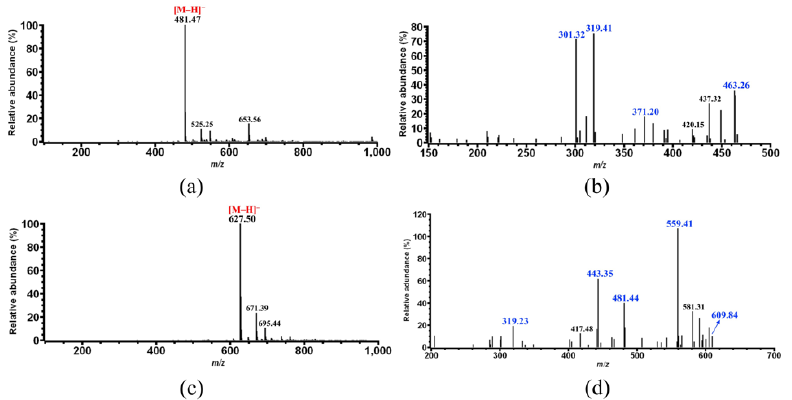
Figure 8. Identification of CP compounds 8 and 9 . ( a ) MS analysis of compound 8 ; ( b ) MS/MS analysis of the ion with m / z 481.47 obtained in ( a ); ( c ) MS analysis of compound 9 ; ( d ) MS/MS analysis of the ion with m / z 627.50 obtained in ( c ).